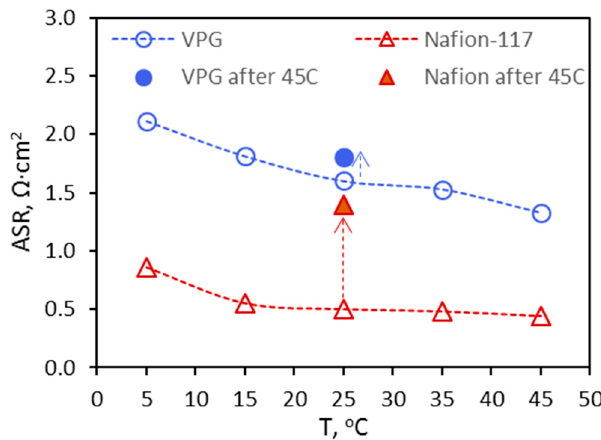
Figure 16. ASR of the VPG and Nafion-117 membranes measured by EIS at different temperatures under VRFB operation conditions.